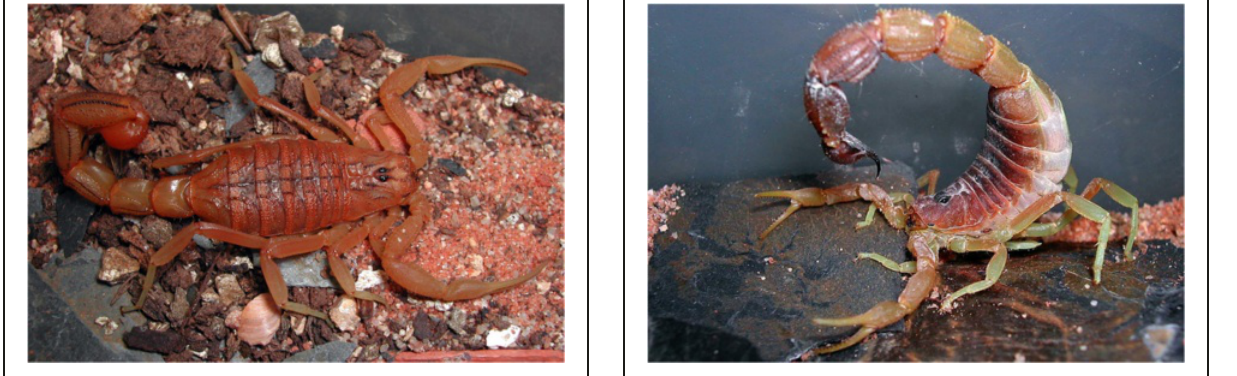
Fig. 12 Parabuthus mossambicensis (Peters, 1861); female from Mozambique (copyright by Eric Ythier, reproduced with